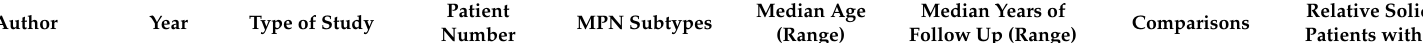
Relative Solid Cancer Occurrence in Comparisons Patients with MPN vs. Comparisons